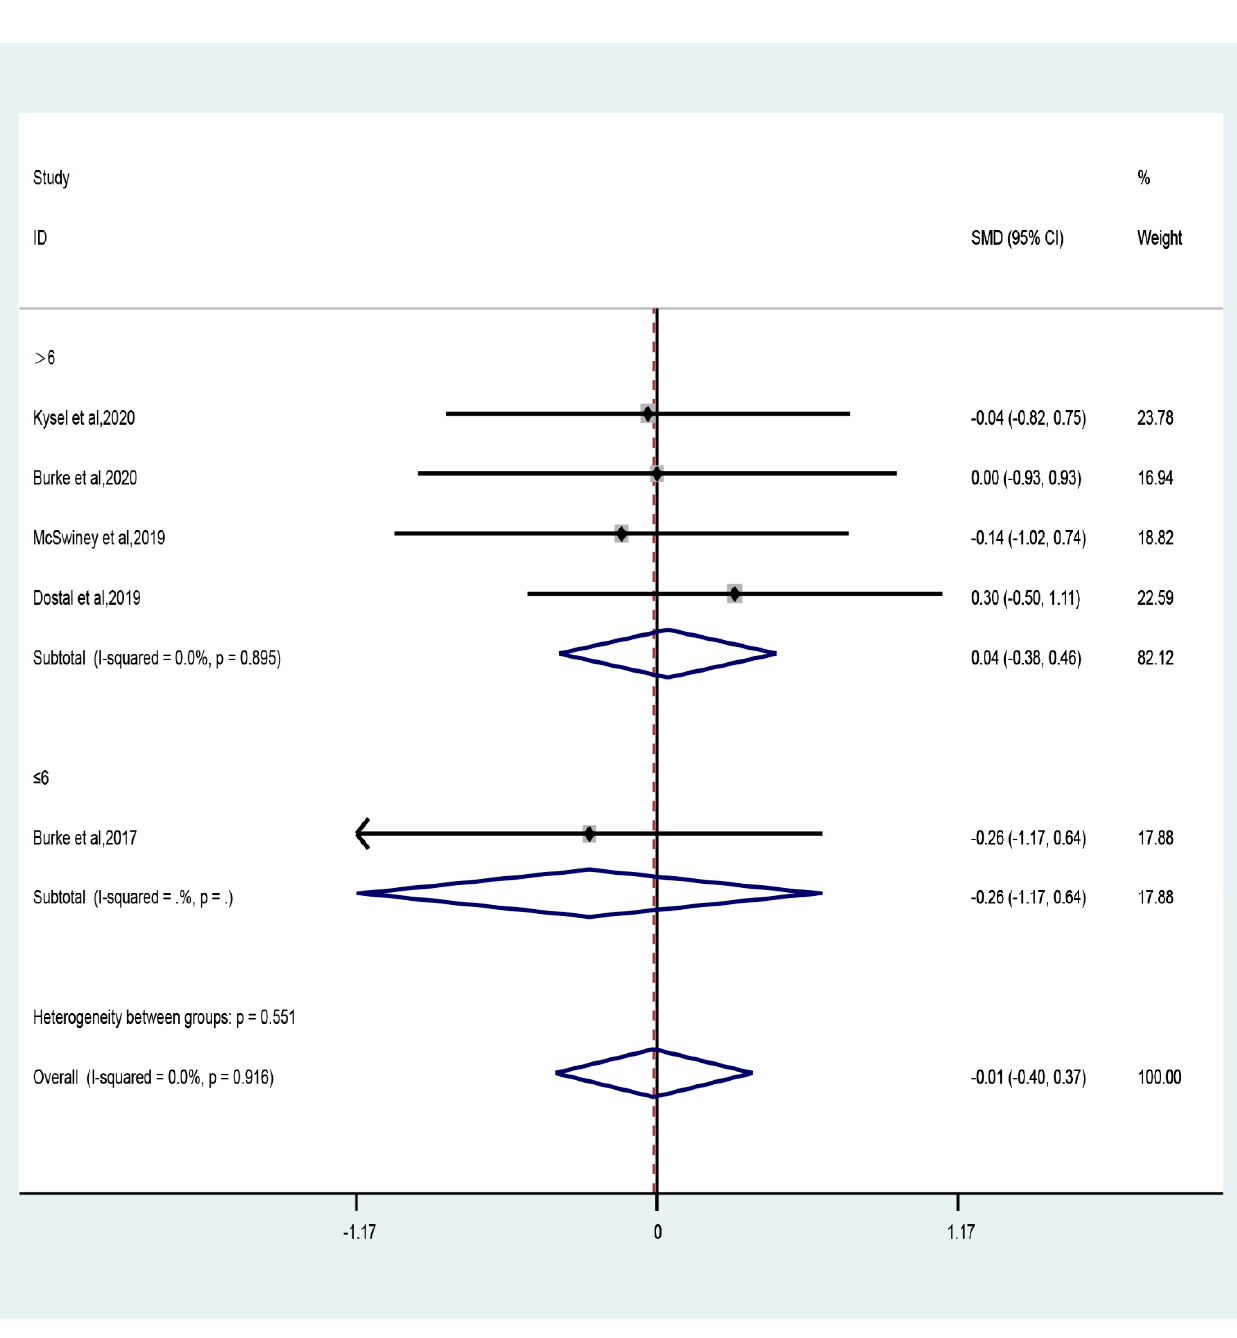
Figure 5. Forest plot of the effect of intervention duration ( ≤ 6 weeks or >6 weeks) on VO 2max [26,31,32,47,50].